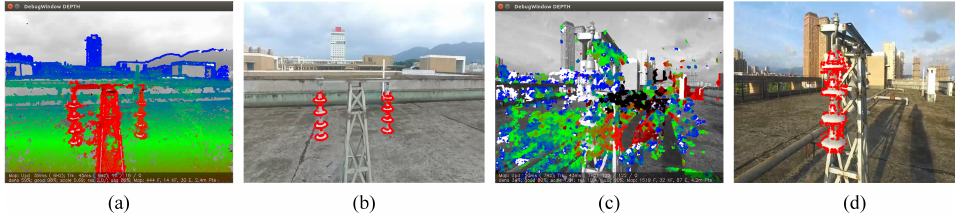
Figure 13. A comparison of the traditional direct method and the proposed fusion-based direct method. ( a ) Dense mapping of LSD-SLAM in stable scene. ( c ) Dense mapping of LSD-SLAM under adverse conditions. ( b , d ) Dense mapping for semantic object using fusion-based direct